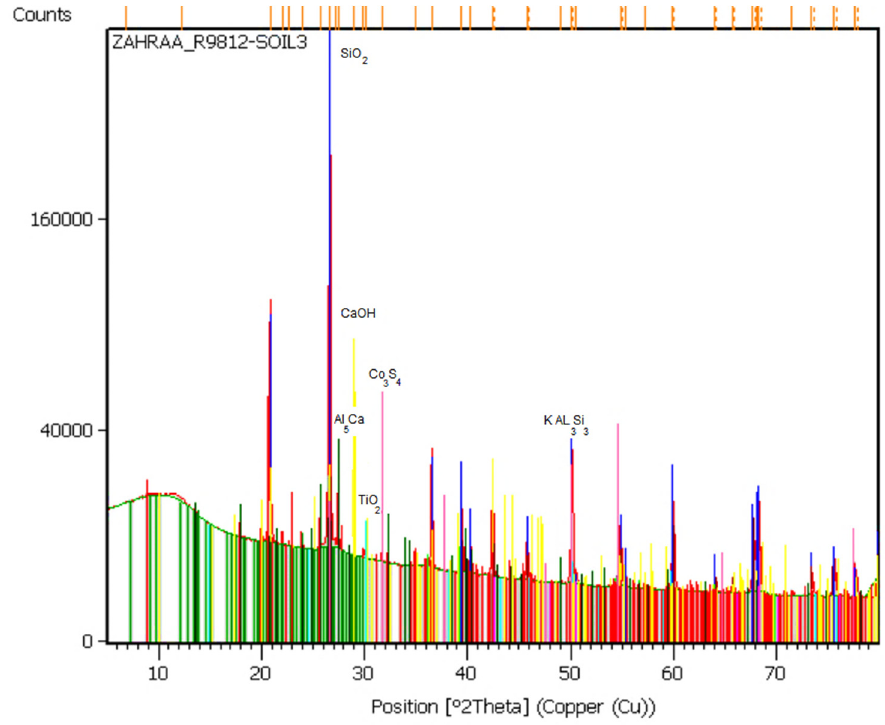
Figure 3. X-ray diffraction pattern of natural soil.